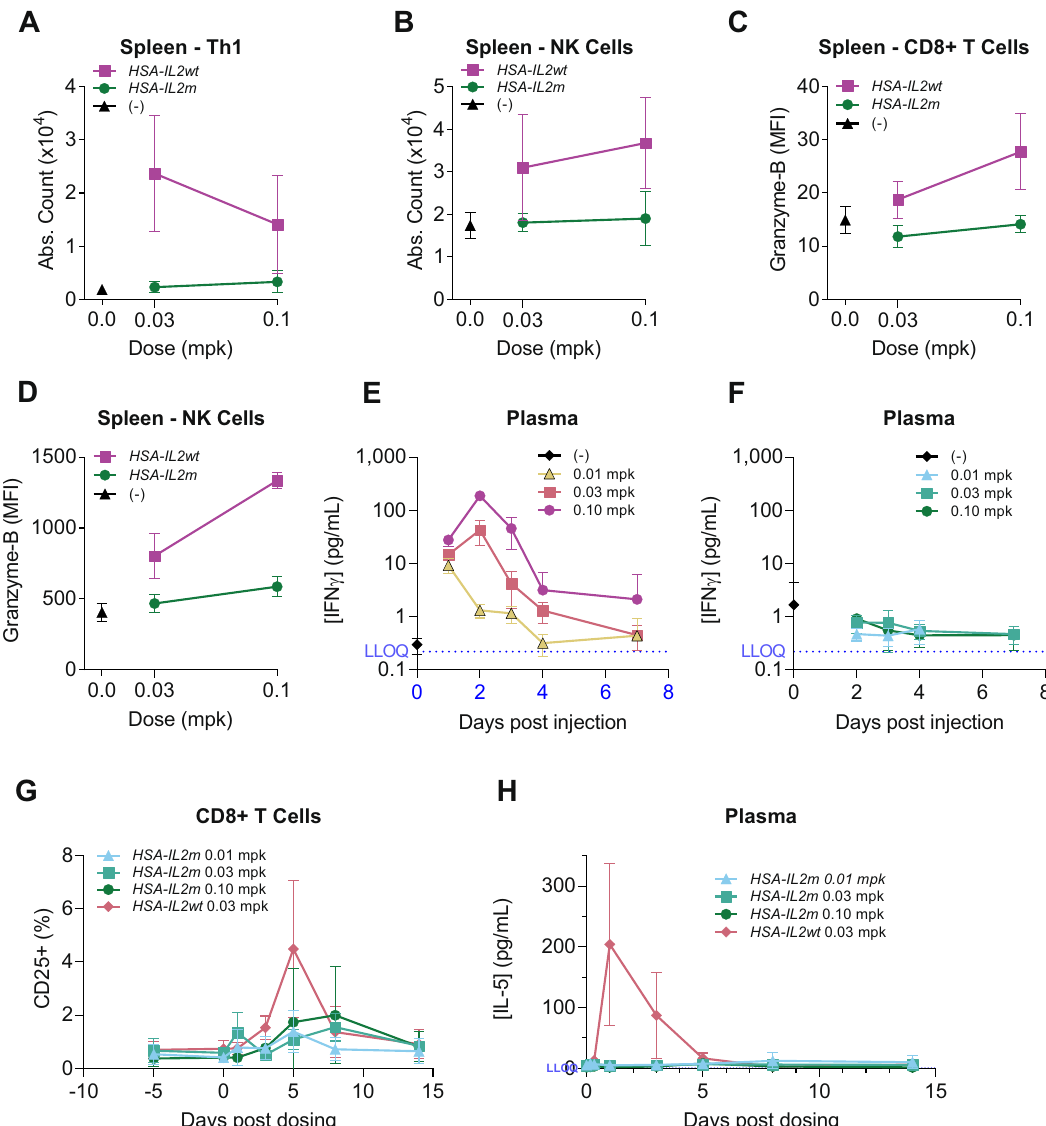
Fig. 4 In vivo enhanced selectivity of HSA-IL2m towards regulatory T cells in mice and non-human primates. In mice, HSA-IL2wt expands proin fl ammatory A Th1 cells (de fi ned as T cells expressing T-bet + and CD4 + ) and B NK cells in spleen and activates C CD8 T cells and D NK cells as shown by upregulation of GZMB ( n = 5). Plasma concentration of IFN γ after administration of E HSA-IL2wt or F HSA-IL2m ( n = 5). In cynomolgus monkey, HSA-IL2wt activates CD8 + T cells ( G ) and stimulates the production of IL-5 ( H ) whereas HSA-IL2m does not at the equivalent and higher doses ( n = 4). Data are presented as mean ± s.d. Source data are provided as a Source Data fi